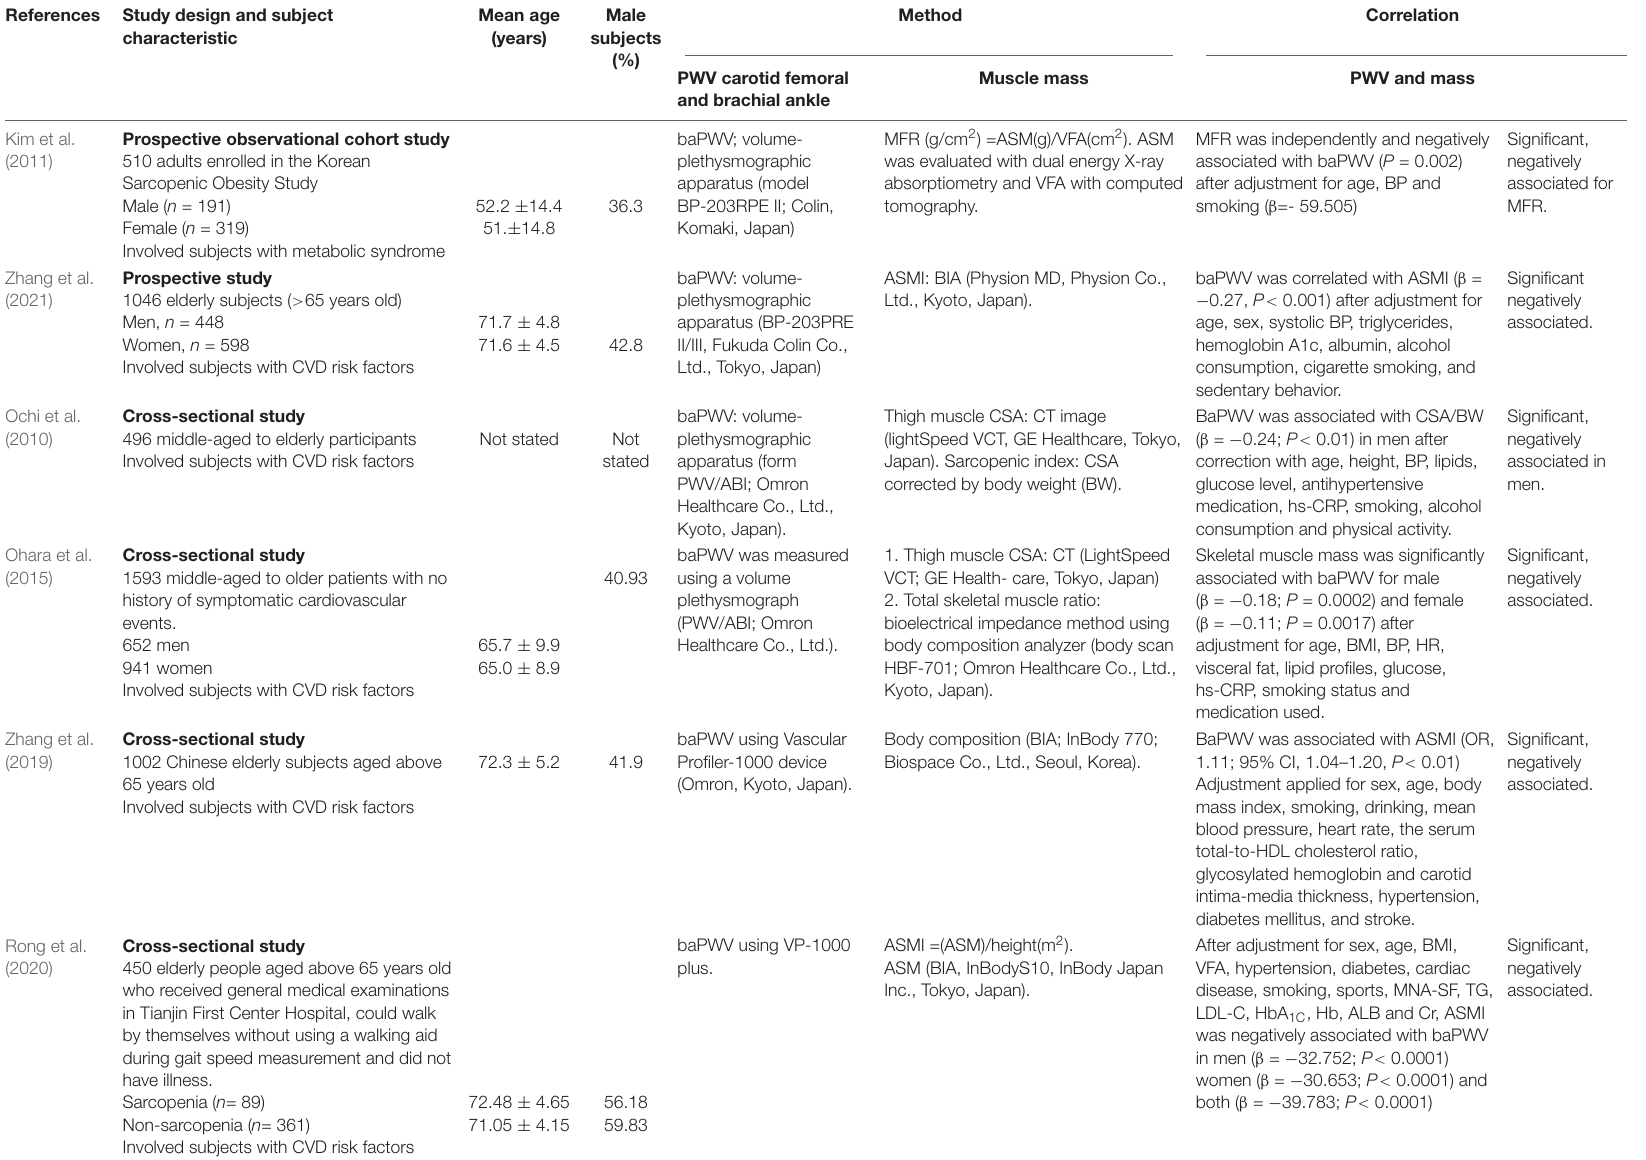
TABLE 3 | Selected studies focusing on the association between arterial stiffness and muscle mass in subjects with cardiovascular diseases or cardiovascular diseases risk